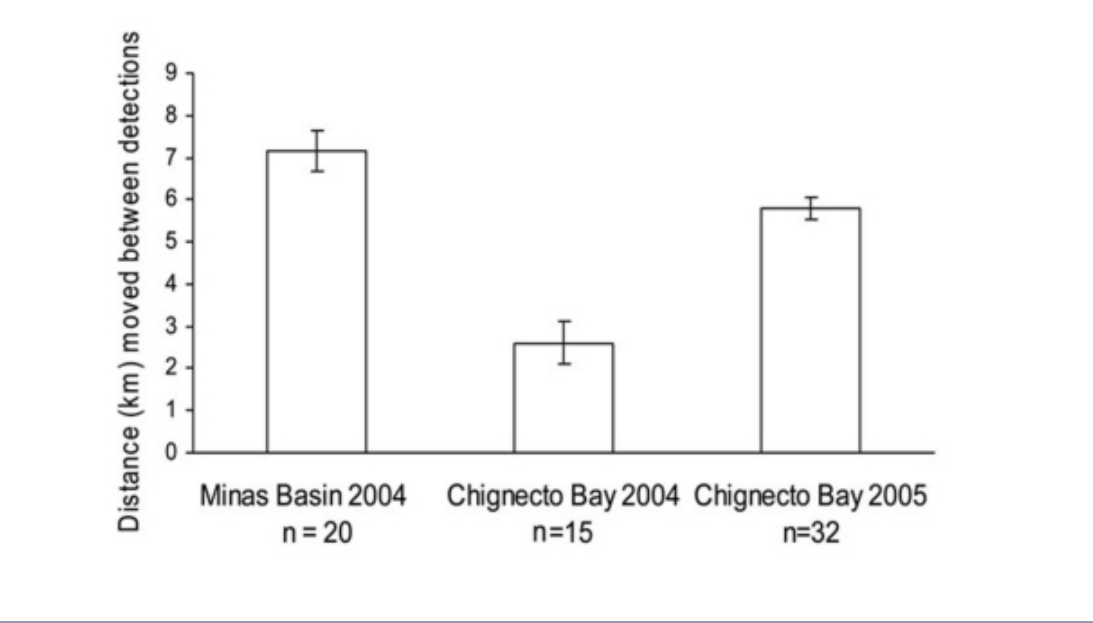
Fig. 2. Distance moved between radio-tracking detections, averaged for individual birds at two locations in 2004 and 2005. Number of birds observed at each location is provided under the location. Error bars are ± 1